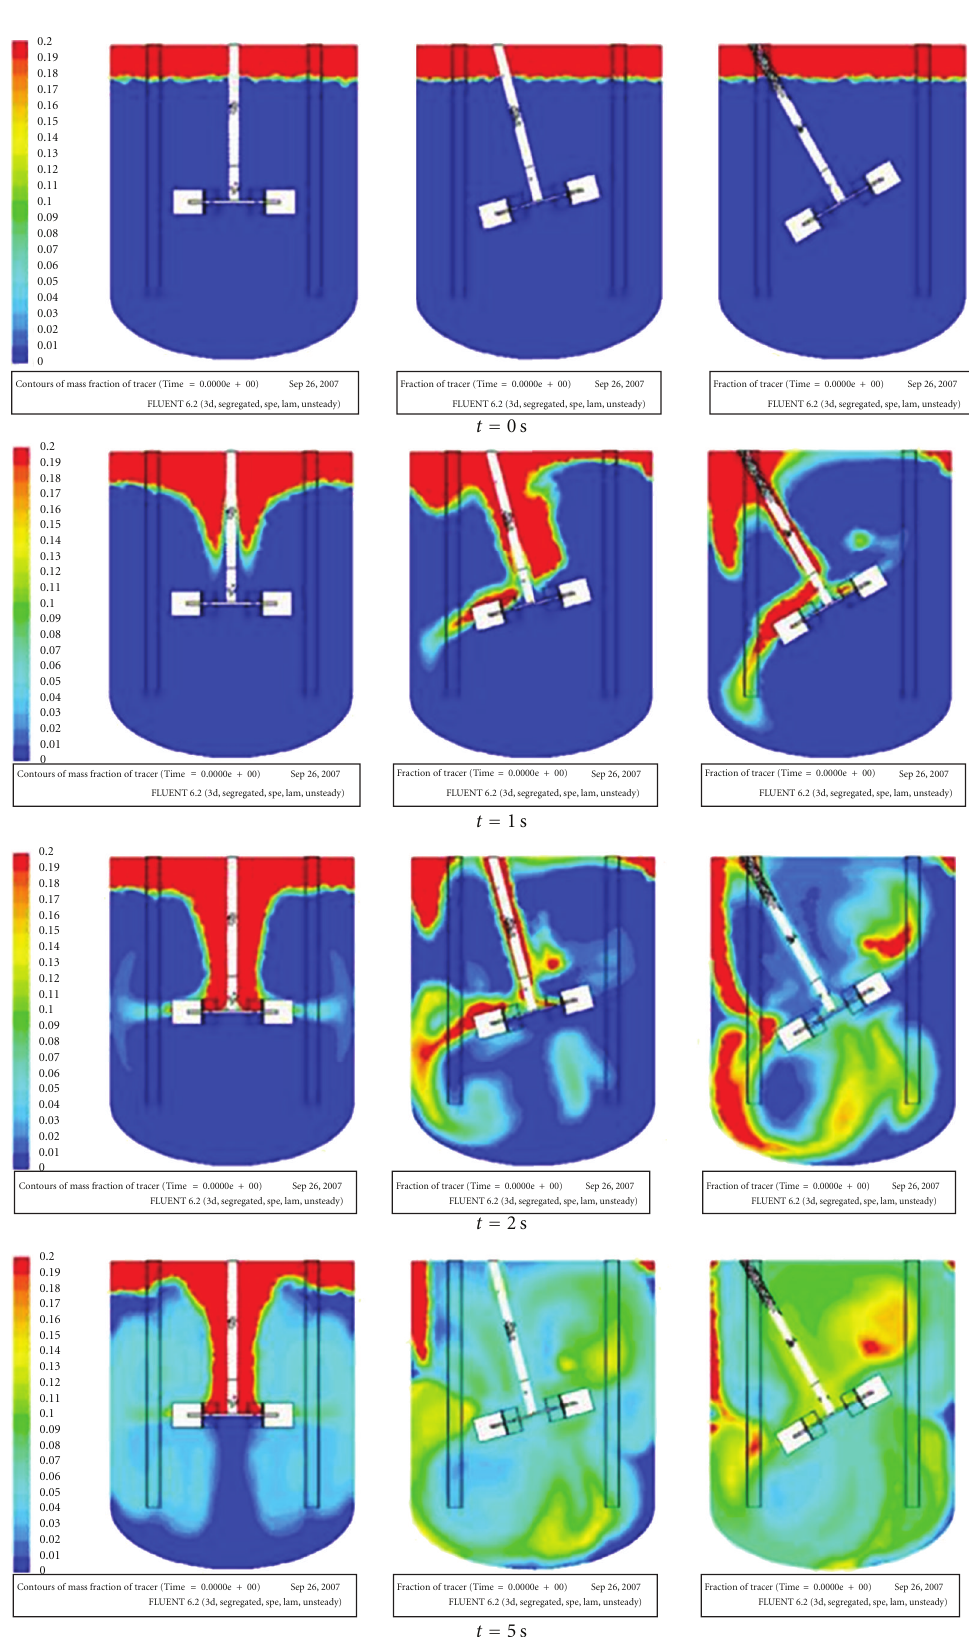
Contours of mass fraction of tracer (Time = 0.0000e + 00) Sep 26, 2007 FLUENT 6.2 (3d, segregated, spe, lam, unsteady)